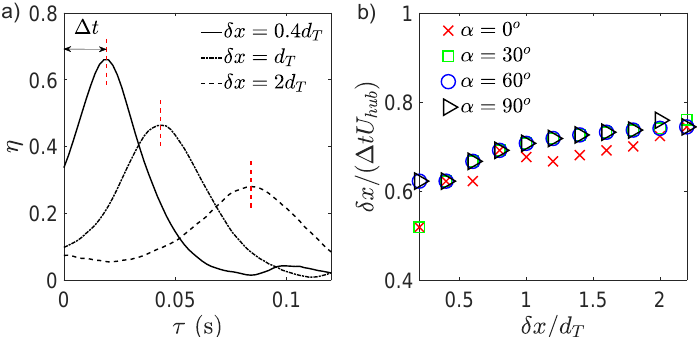
Figure 14. ( a ) cross-correlation function η ( τ ) for selected case under α = 0 ○ ; ( b ) normalized time-delay of wake transport across various downstream distances and α